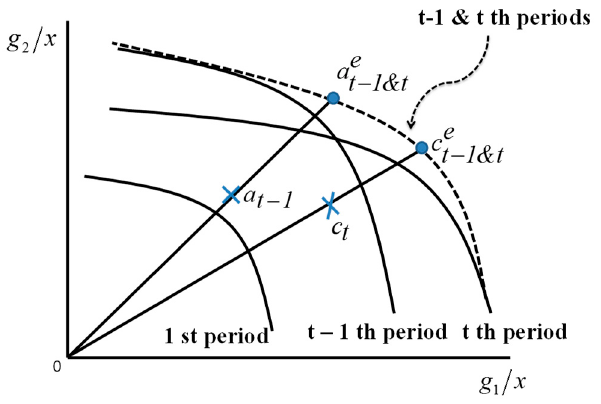
Figure 4. Frontier crossover under natural disposability.